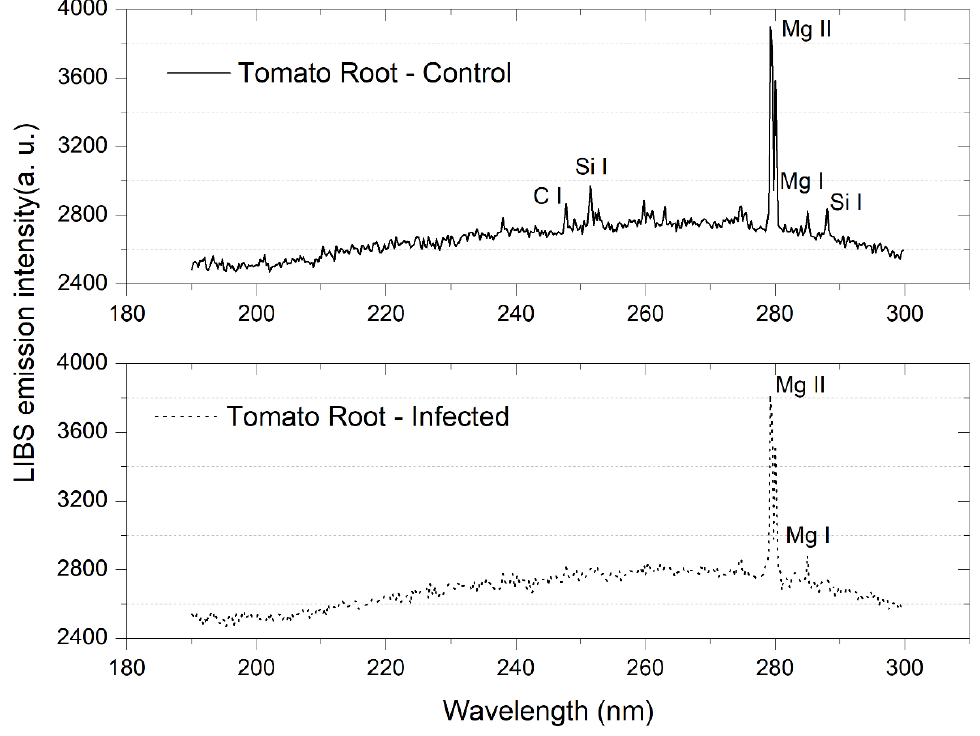
Figure 7. LIBS spectra of control and M. incognita -infected tomato roots.